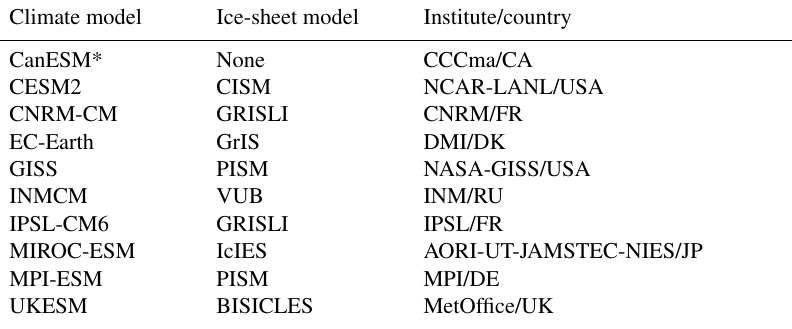
Table 3. Climate modeling centers that have expressed an interest in ISMIP6. * indicates only an interest in the diagnostic component (no AOGCM–ISM participation